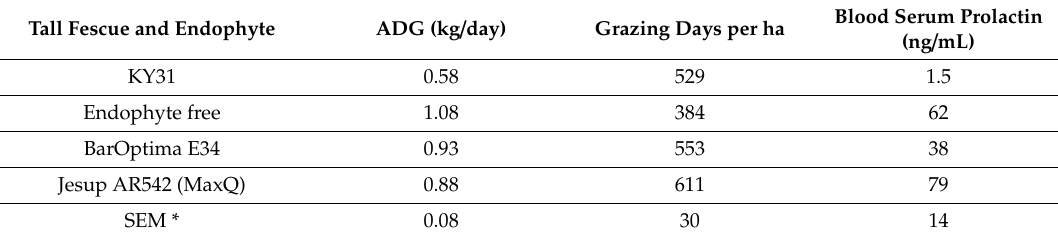
Table 9. Mean over two years average daily gain (ADG), grazing days per ha, and blood serum prolactin levels (in February) of 11 month old calves grazed on di ff erent endophytic tall fescue pastures in the Coastal Plain region of southwestern Arkansas. (Taken from